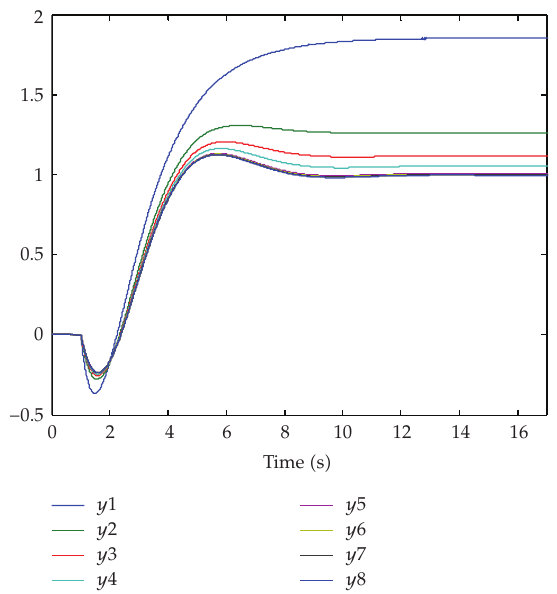
Figure 7: The influence of the additional constrains.